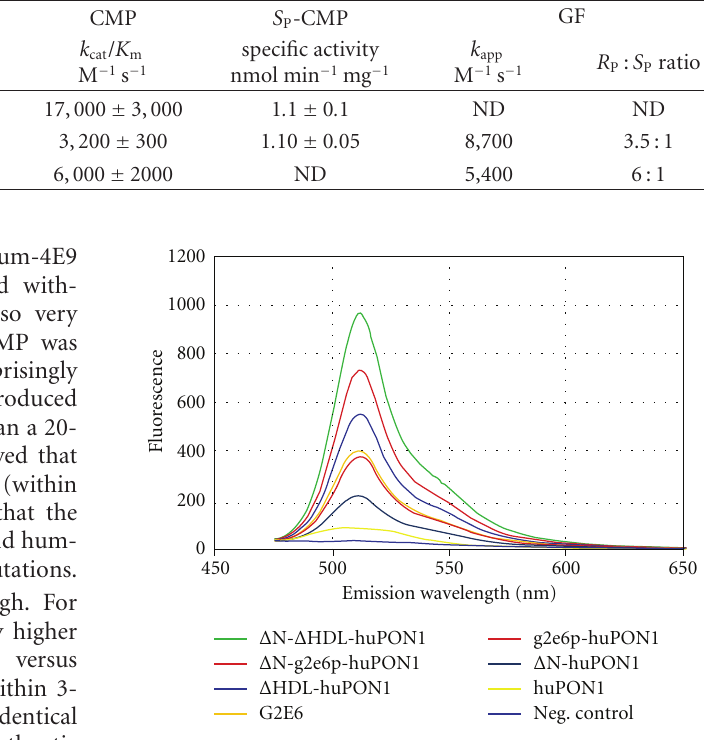
Figure 4: GFP-fusion screening for solubility. The fluorescence level is shown for normalized numbers of cells in PBS with frGFP fusions of the PON1 variants. Results from multiple trials typically varied by less than 10%. Negative control cells contained no frGFP fusion. For clarity, the constructs are listed in the legend in the same order from top to bottom as the maxima of the emission